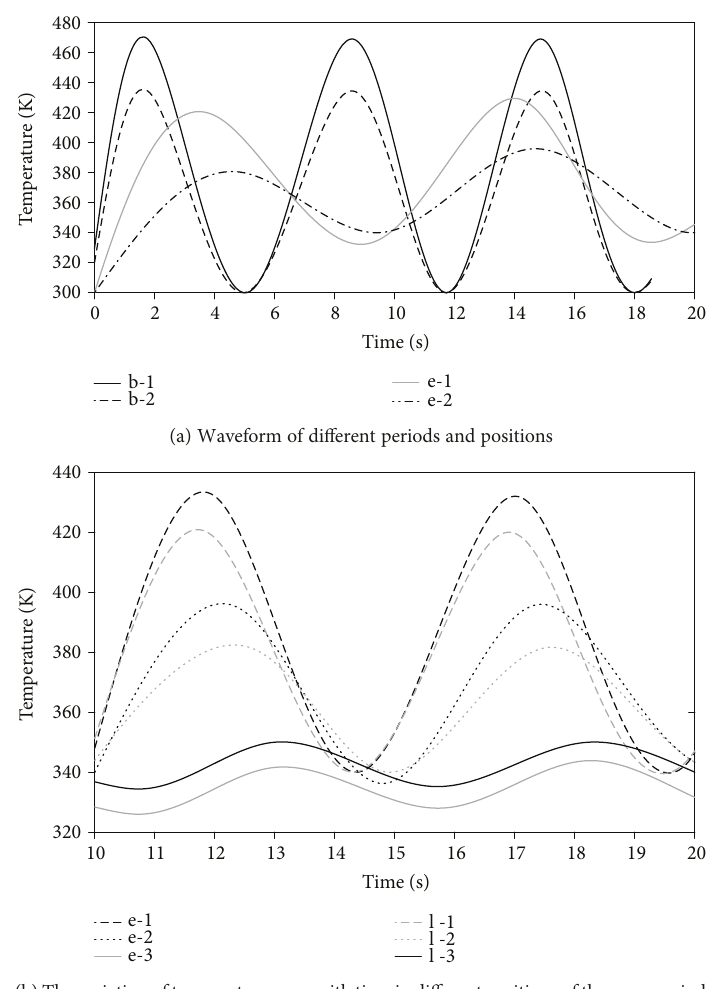
Figure 4: Curves of waveform versus